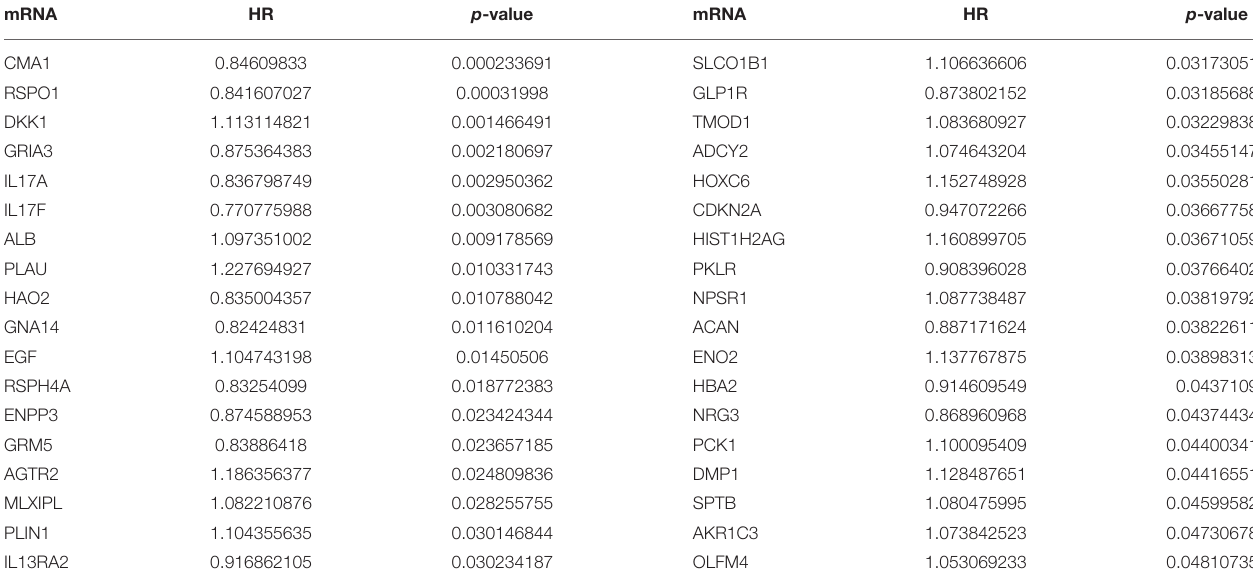
TABLE 7-3 | mRNA univariate Cox regression